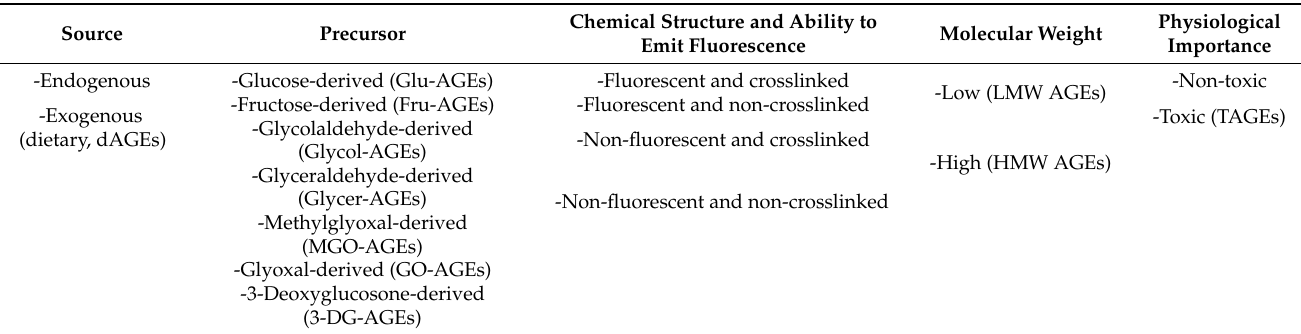
Table 1. Classification of AGEs with respect to different